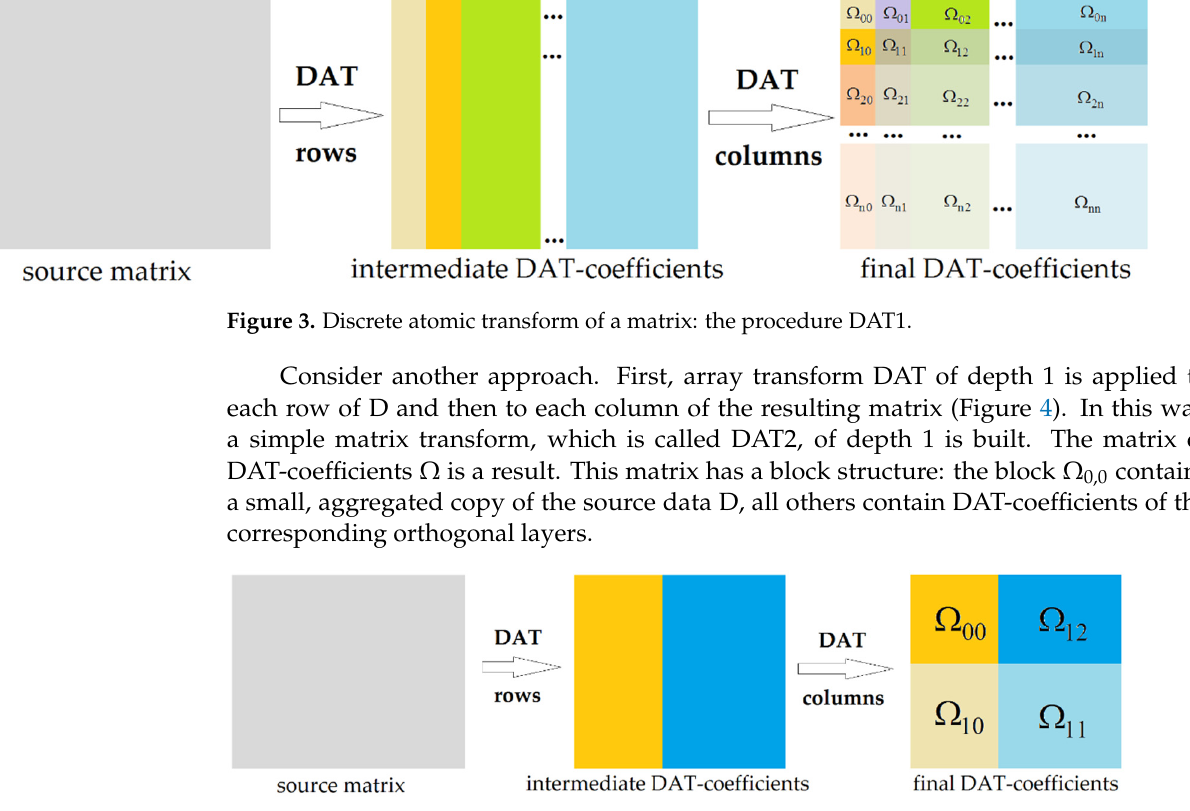
Figure 4. Discrete atomic transform of a matrix: the procedure DAT2 of depth 1.